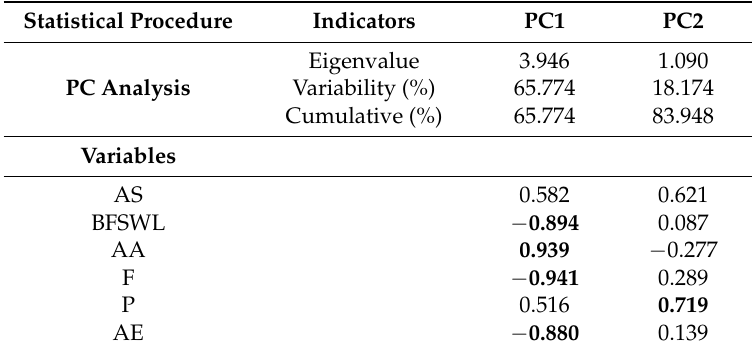
Table 6. Principal component analysis (PCA) of catchment attributes that are most correlated with groundwater